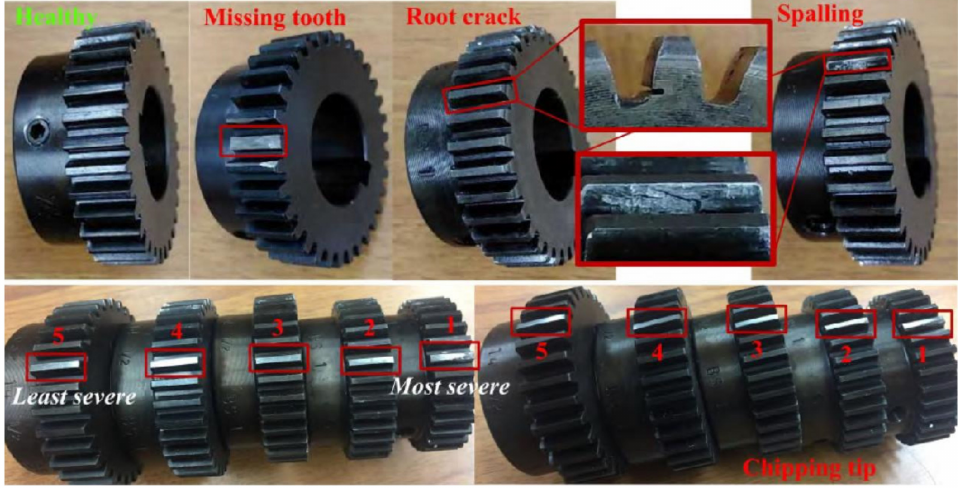
Figure 6. Nine working conditions, including healthy state and eight types of fault